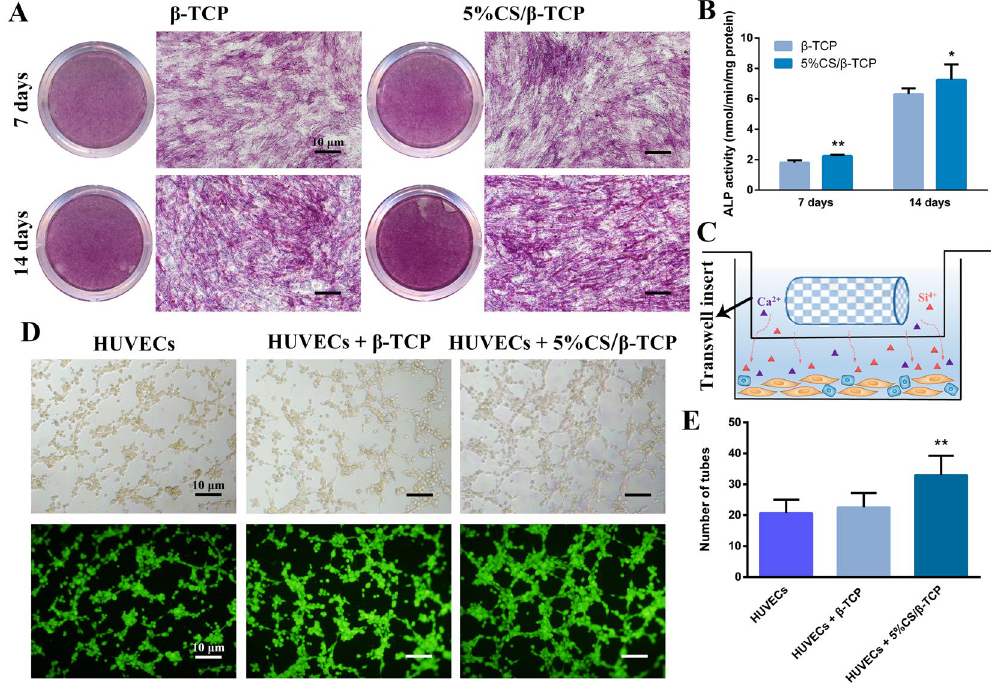
Figure 3. 5%CS/ β -TCP scaffolds stimulate hBMSC osteogenesis and HUVEC angiogenesis in vitro . ( A ) ALP staining in hBMSCs cultured for 7 and 14 days with β -TCP scaffolds or 5%CS/ β -TCP scaffolds in transwell inserts. ( B ) 5%CS/ β -TCP scaffolds stimulated ALP activity at 7 days and 14 days in comparison to pure β -TCP. ( C ) Schematic representation of transwell experiments. Scaffolds in Transwell inserts (upper chamber), cells in the lower chamber. ( D ) Tube formation by HUVECs, as observed by light microscopy (top) and Calcein AM staining (bottom), after 4 h on Matrigel with β -TCP or 5%CS/ β -TCP scaffolds in transwell inserts. ( E ) 5%CS/ β - TCP scaffolds enhanced tube formation in comparison to β -TCP scaffolds. * p < 0.05; ** p < 0.01. Scale bar represents 10 μ